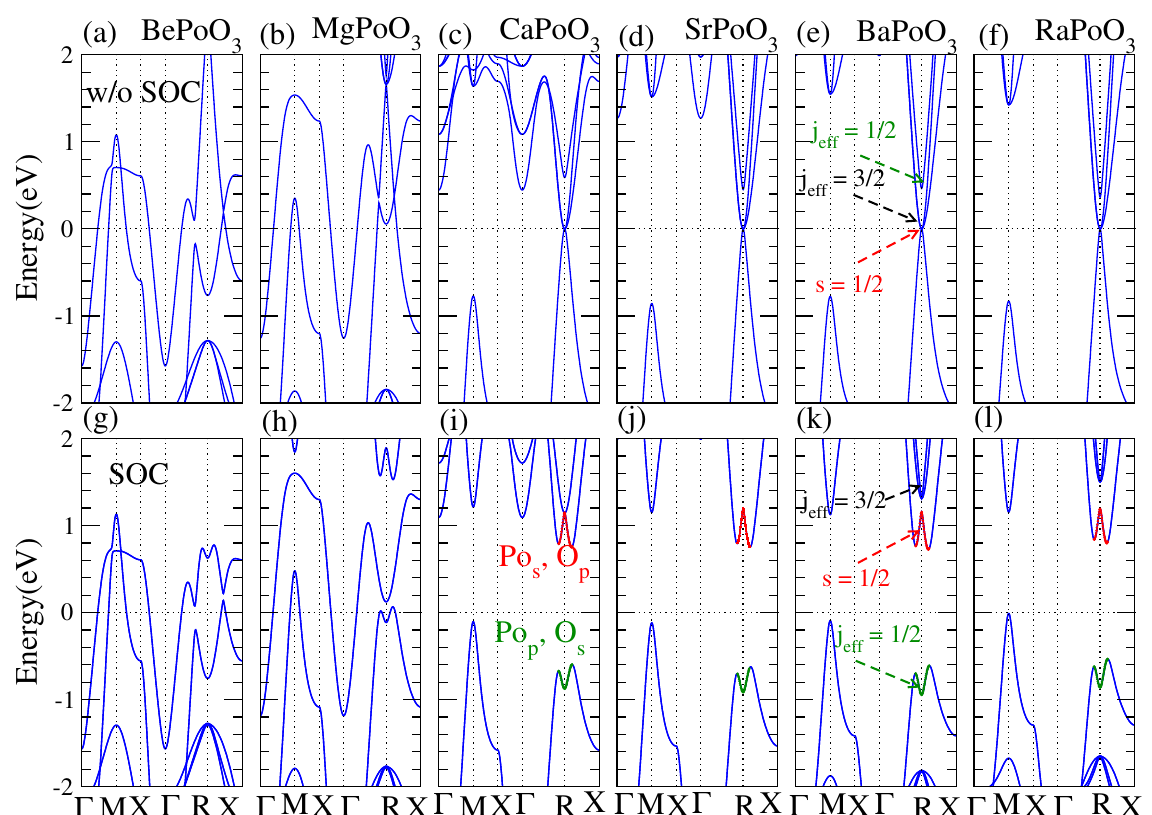
Figure 2. Scalar relativistic band structures, ( a – f ) upper panel , and fully relativistic band structures, ( g – l ) bottom panel for APoO 3 perovskite. The Fermi level is shifted to zero as the reference. Without SOC effect, ( a ) BePoO 3 , ( b ) MgPoO 3 , ( c ) CaPoO 3 , ( d ) SrPoO 3 , ( e ) BaPoO 3 , and ( f ) RaPoO 3 are metals while there are Dirac corn-like band appeared at R point. The highest occupied band at R point is singlet s = 1/2 and the lowest two bands are j ef f = 3/2 and 1/2. When the SOC effect is included, ( g ) BePoO 3 and ( h ) MgPoO 3 are metals, however ( i ) CaPoO 3 , ( j ) SrPoO 3 , ( k ) BaPoO 3 , and ( l ) RaPoO 3 are insulators. The metal to insulator transition appears due to the SOC effect and the s = 1/2 and j ef f = 1/2 bands flipped, see ( e ) and ( k